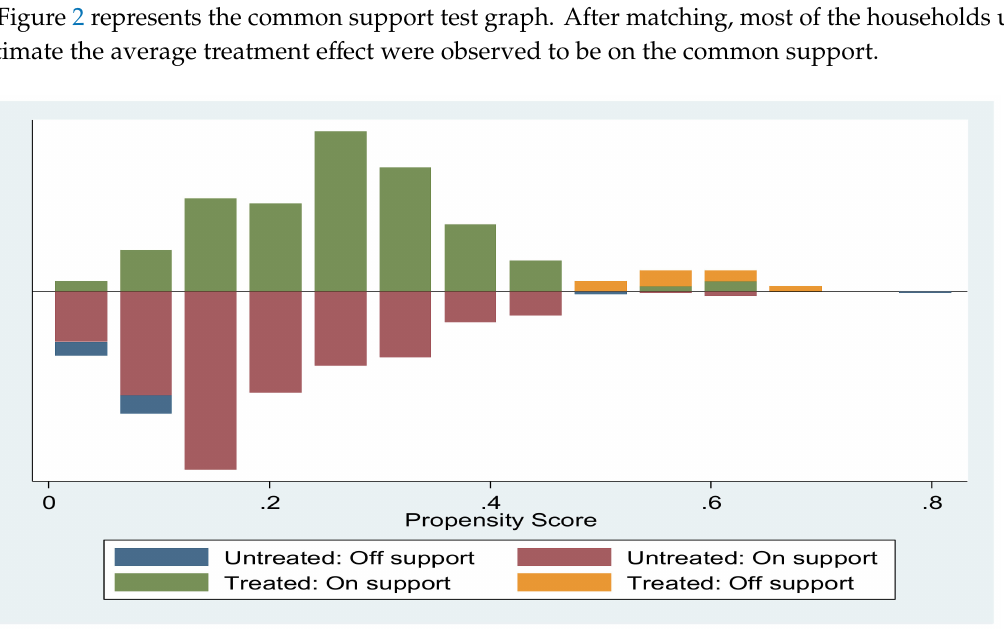
Figure 2. Common support test.